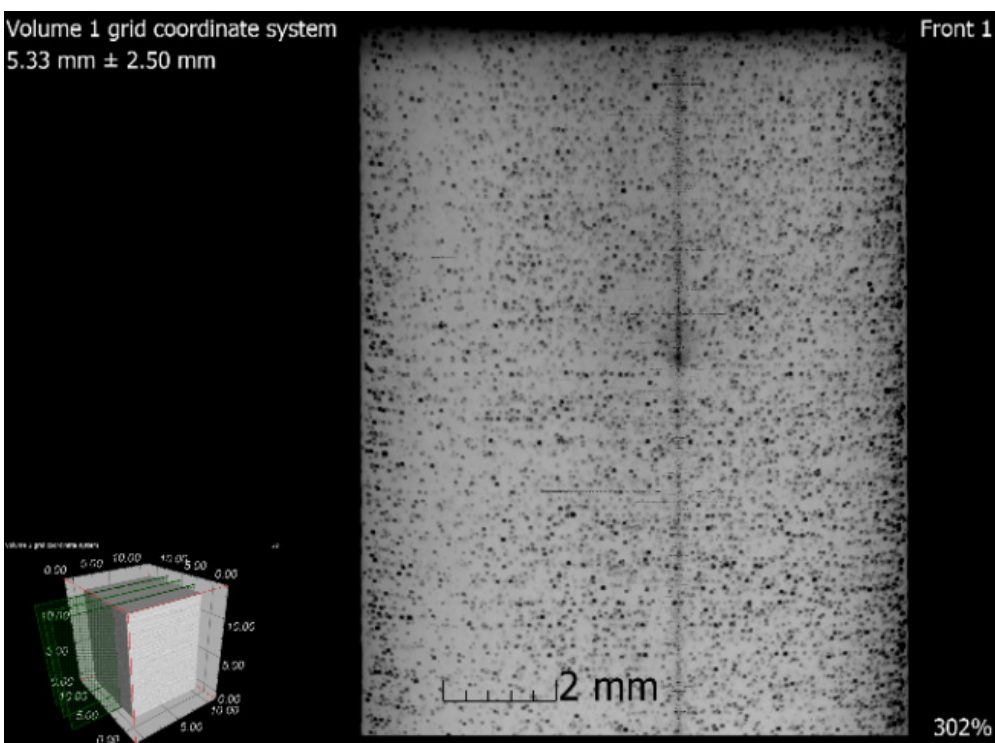
Figure 17. Tomographic CT sections of sample 5 after SLM (XZ plane). Materials 2020 , 13 , x FOR PEER REVIEW